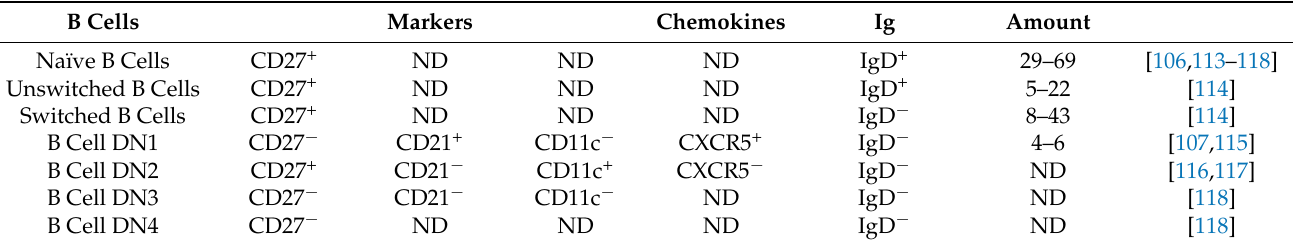
Table 3. B cell phenotypes (adapted from Li et al.) [107]. Copyright permission refer to citations and/or Supplementary Data S2, also see Figure